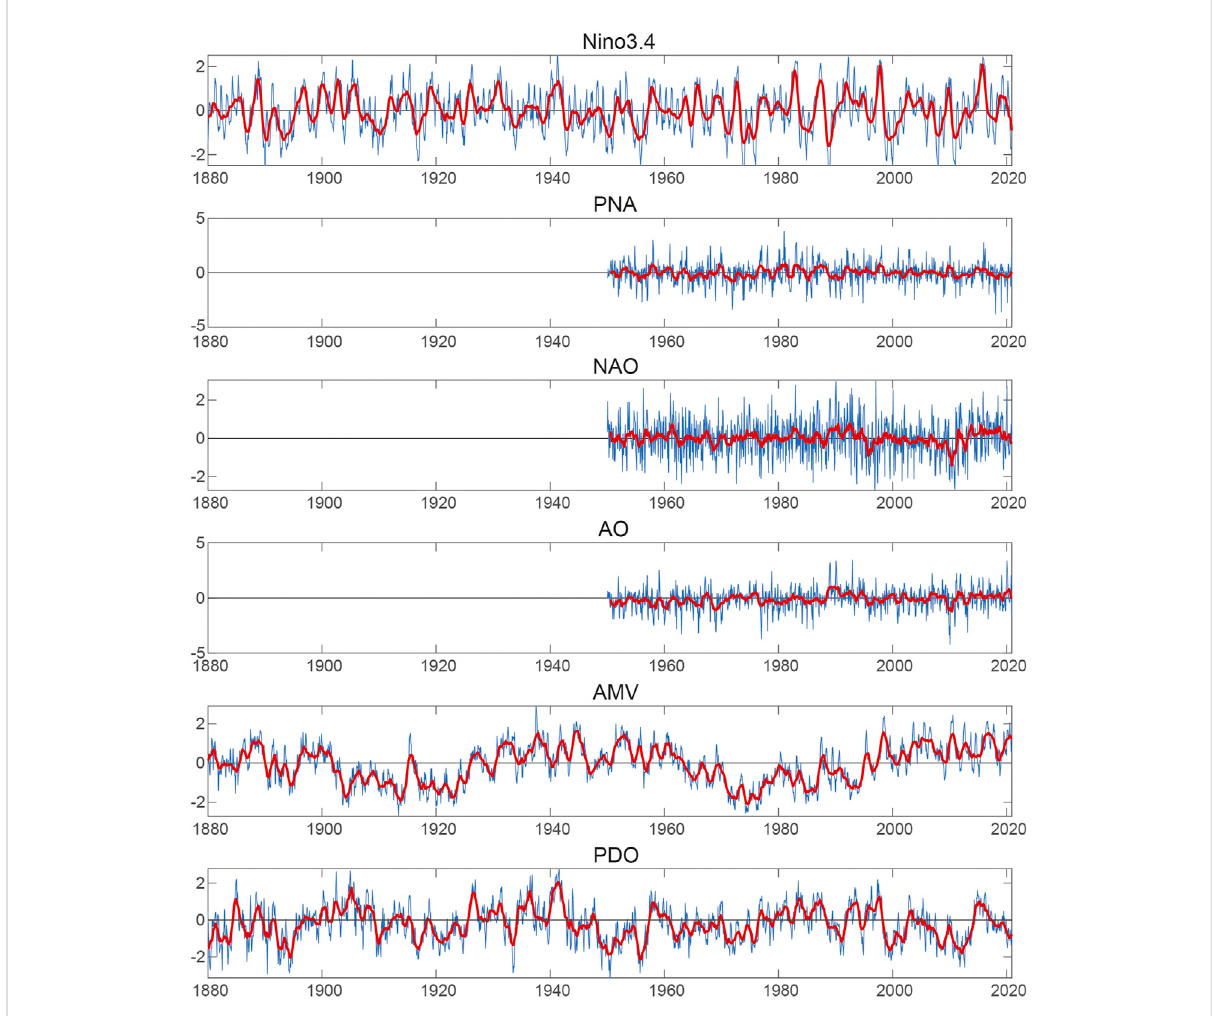
Time series of annual standardized climate indices for available periods of record (blue lines are monthly values, red are 13-month moving averages).NAOandAOindicesarefromtheClimatePredictionCenter;AMVandPDOindicesaredeterminedusingtheExtendedReconstructedSea Surface Temperature (ERSST) data set version 5 (Huang et al., 2017). Source: